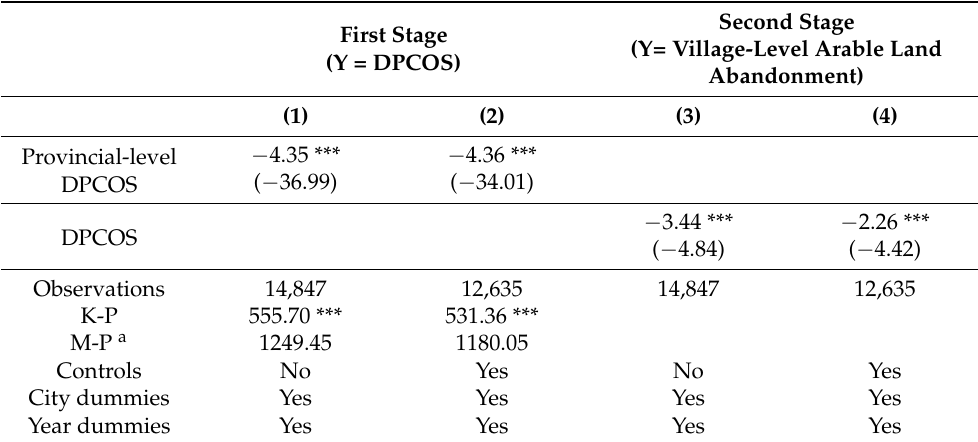
Table 7. Replacing core outcome